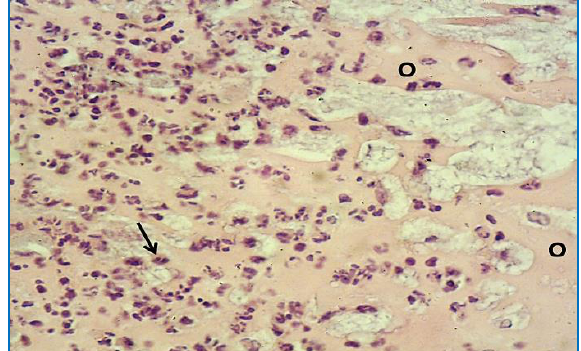
Figure, 3: Section of skin (7 days post injury-control) shows: Inflammatory cells (arrow), (H), edema. H and E stain. 400x.